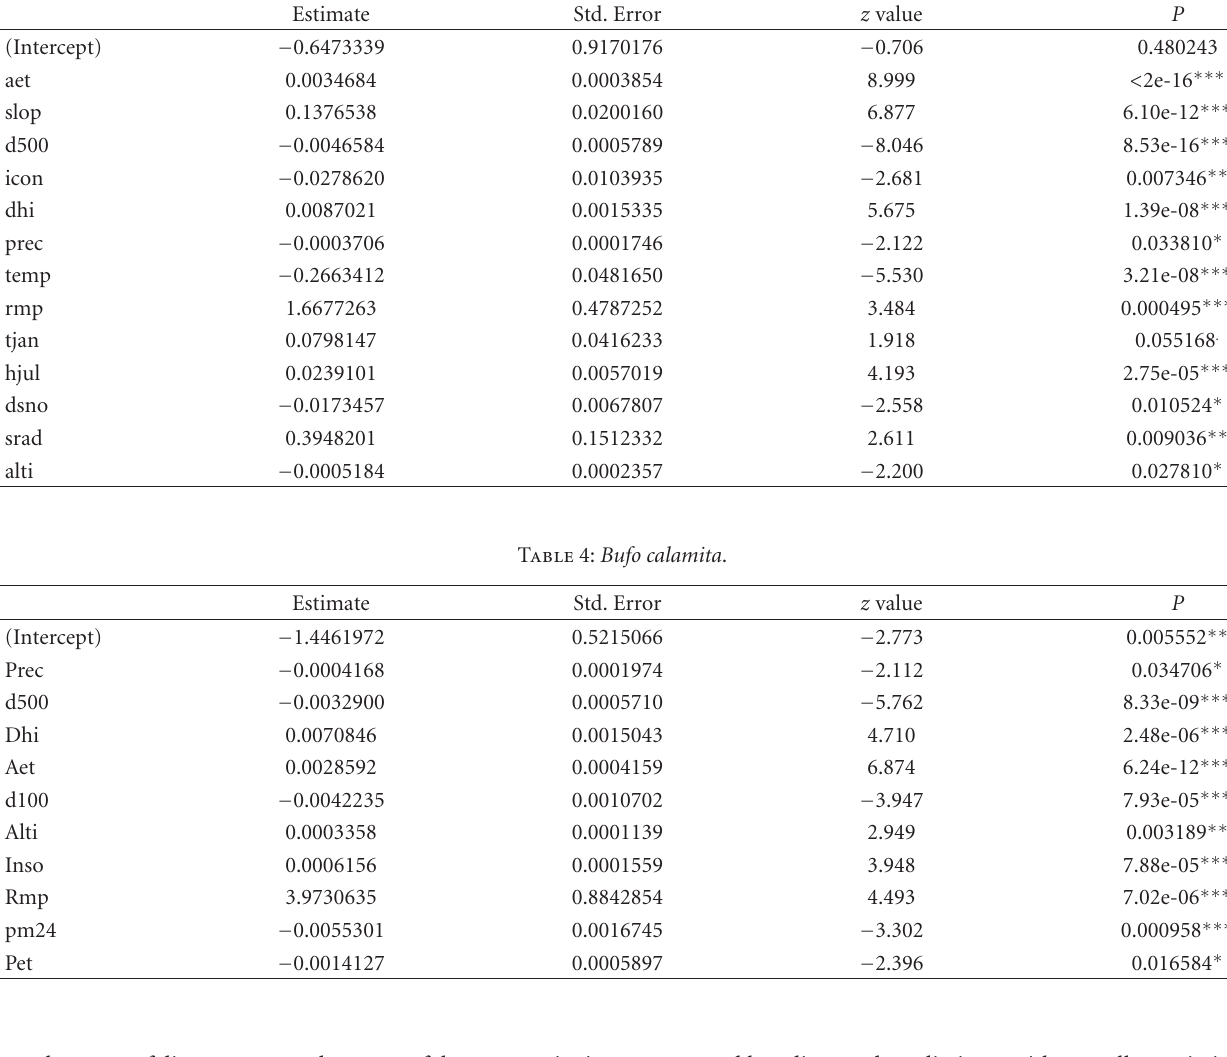
Table 3: Bufo bufo .